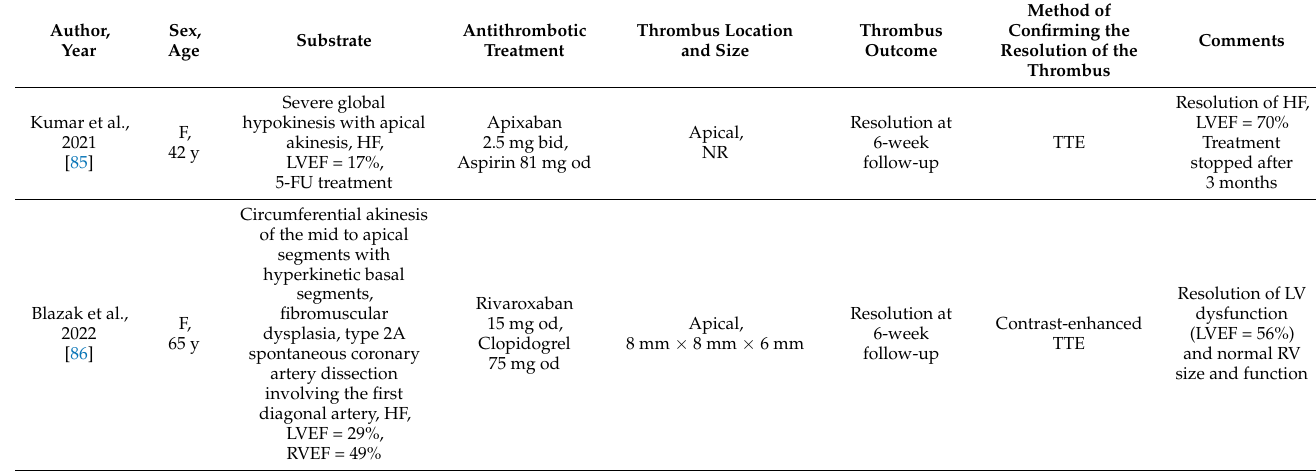
Table 3. LV thrombus in patients with Takotsubo